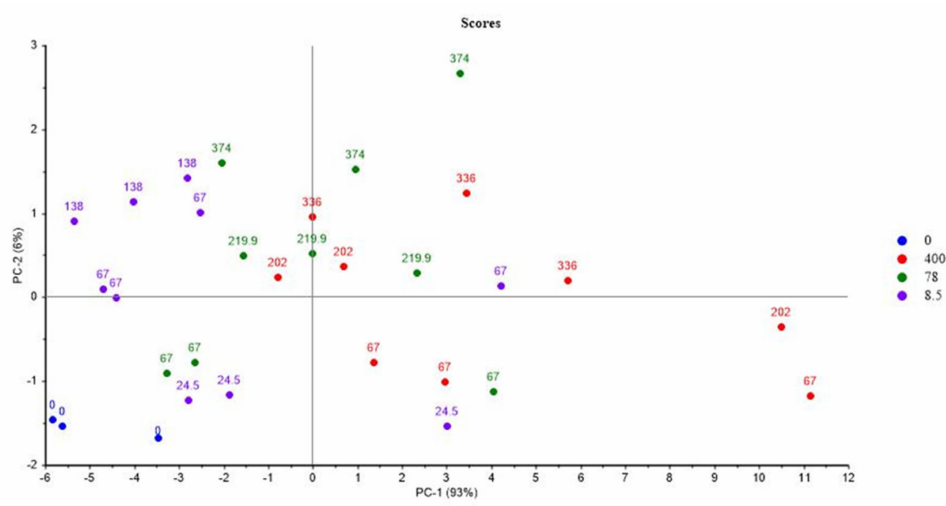
Figure 9. PCA results on Mod5: UJV irradiation dose rate (Gy/h) with location of the second step of irradiation.